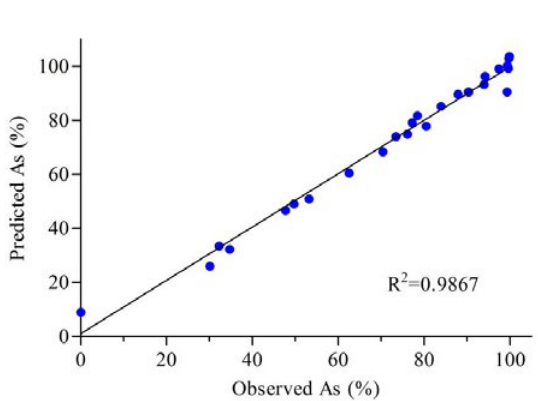
Fig. 3: Correlation of the predicted and actual results of the response